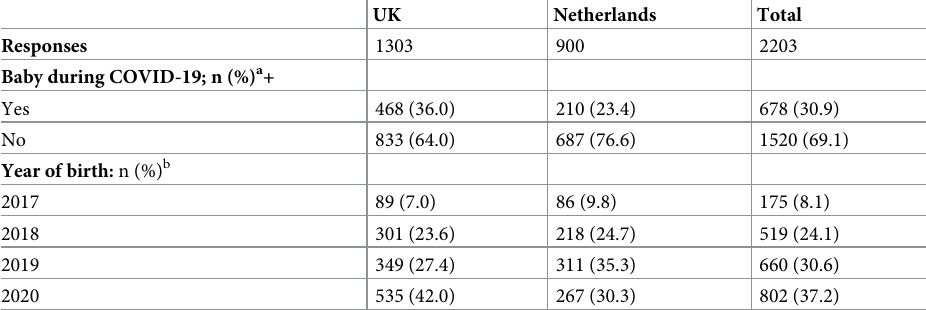
Table 1. Babies born better survey responses in relation to COVID-19 pandemic.